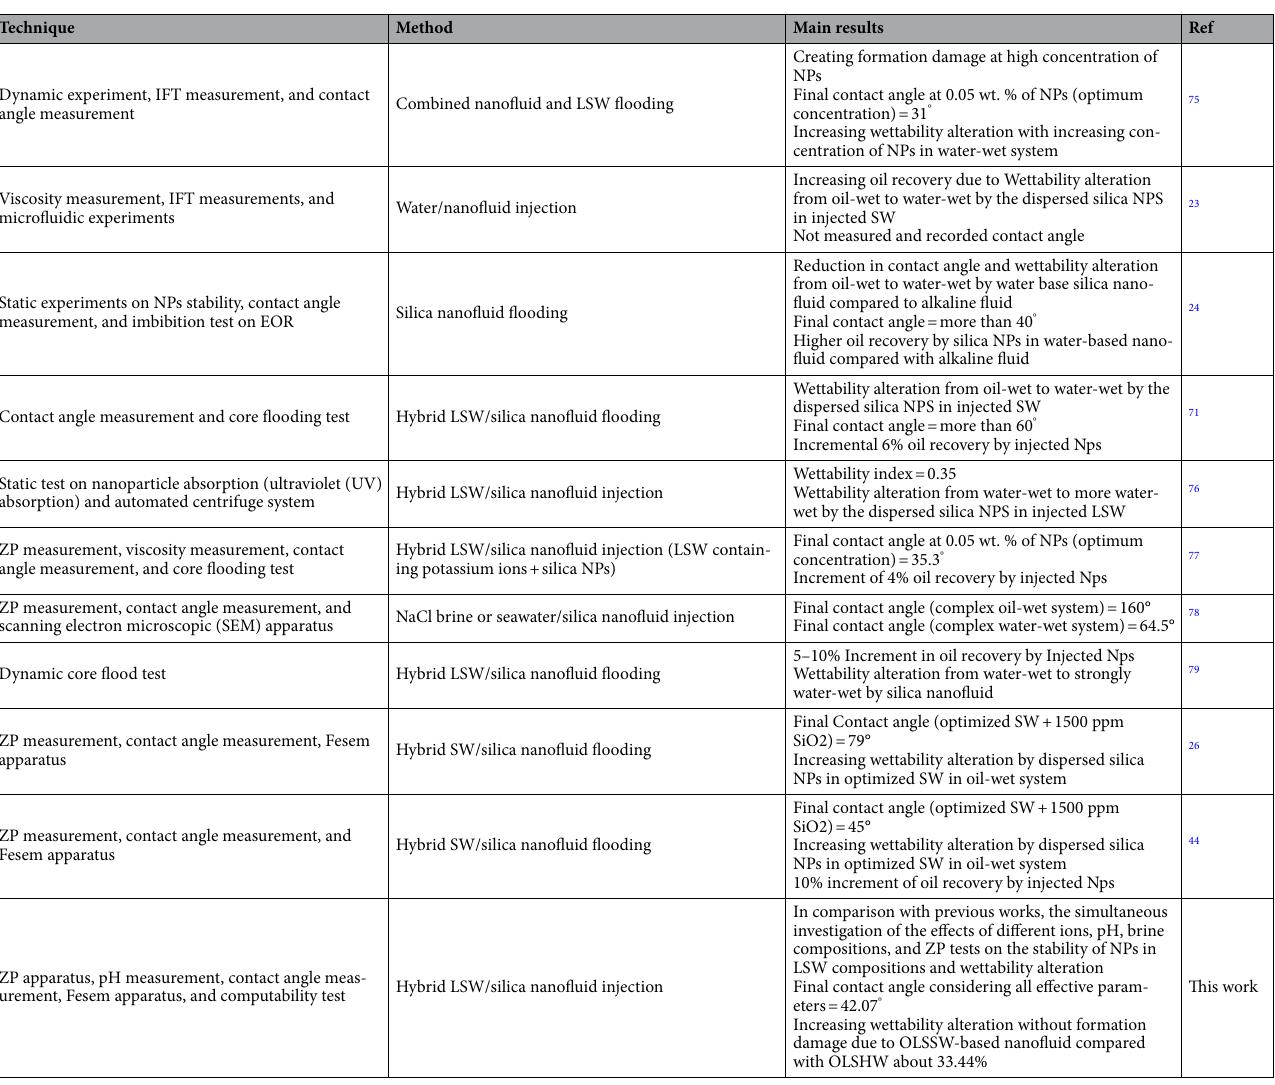
Table 17. Comparison between the effect of silica NPs in the LSW solution in this study with previous